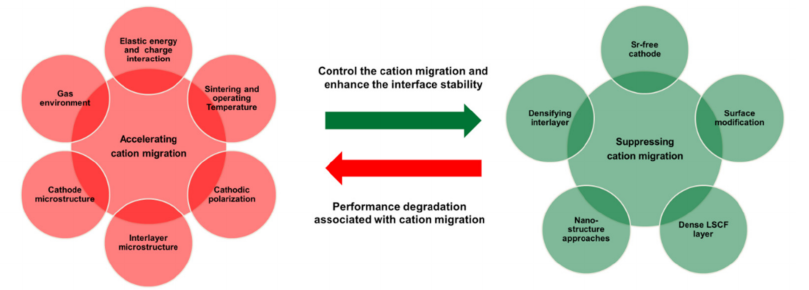
Figure 13. Factors influencing the cation migration and strategies to enhance the interface stability in the LSCF-based cathode materials for solid oxide fuel